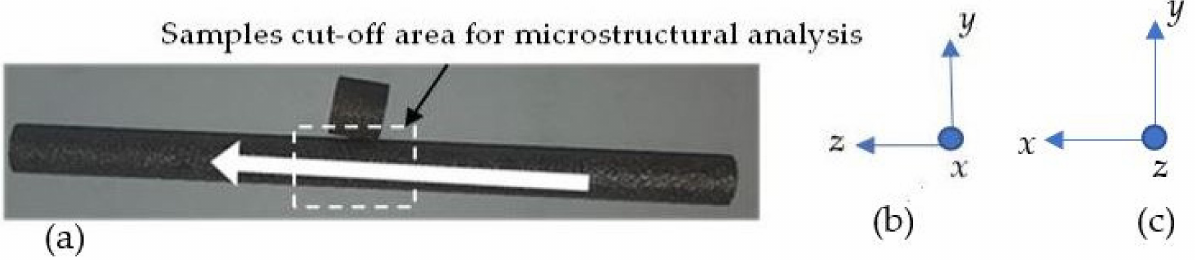
Figure 1. ( a ) A typical fabricated cylindrical rod of DMLS Ti6Al4V(ELI) that was then cut up into cylinders of 6 mm height for microstructural analysis and further tests. In ( a ), the white arrow shows the build orientation, ( b ) the EOSINT M280 machine standard co-ordinate system and ( c ) the coordinate system of the SEM used for this study with reference to the orientation of